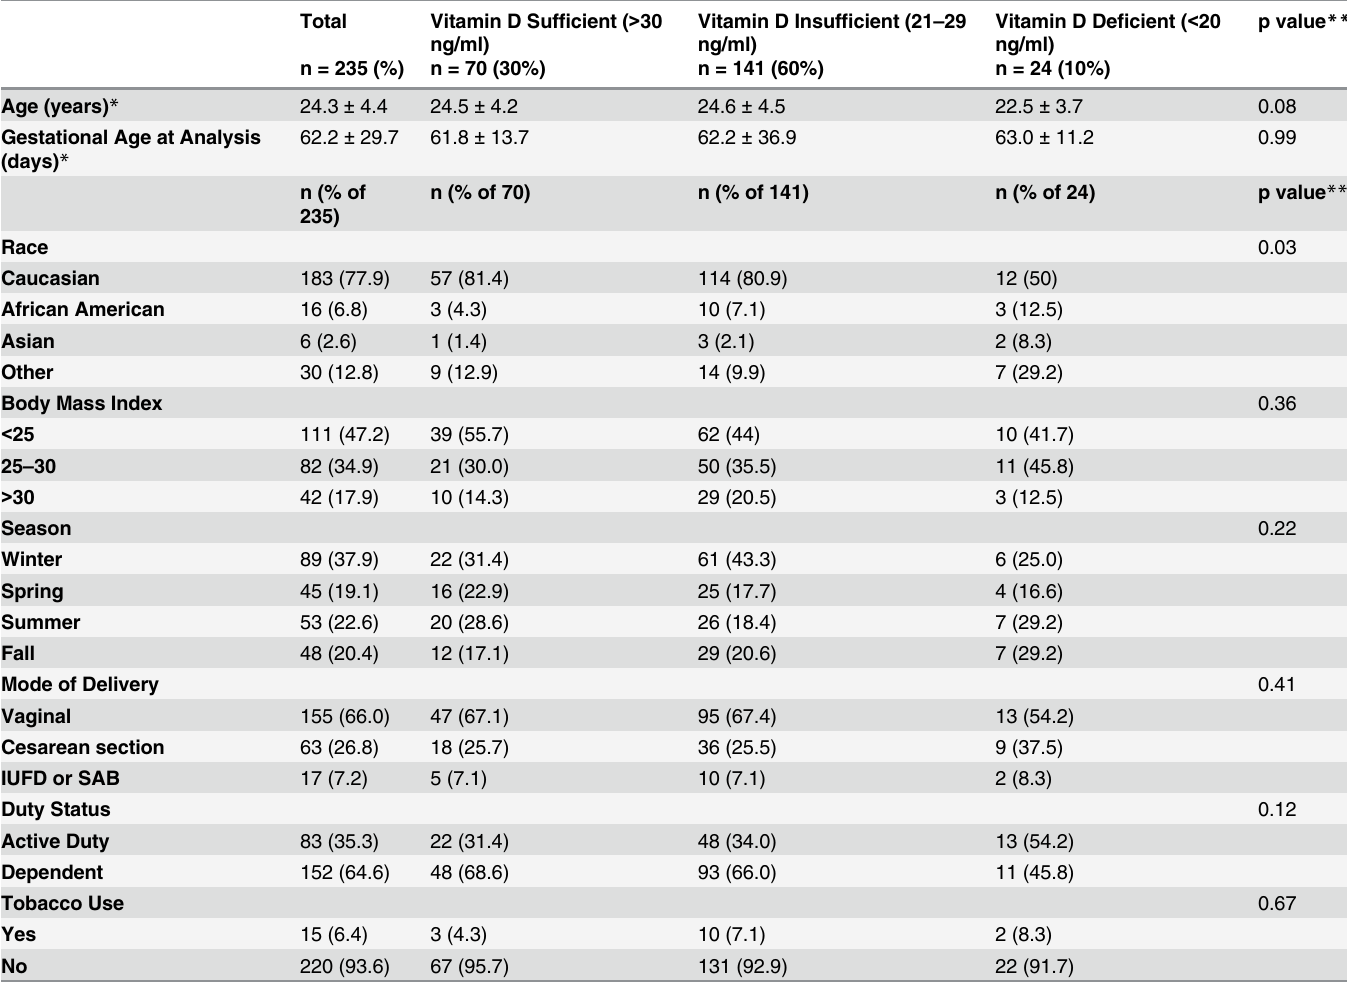
Table 2. Demographics of the study population by vitamin D